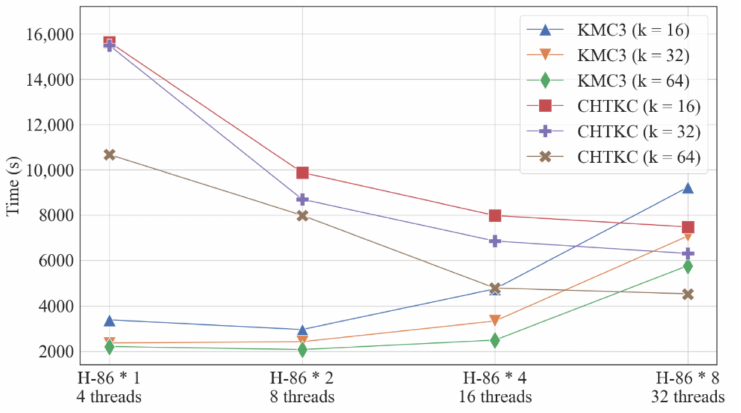
Figure 8. Weak scalability comparison of KMC3 and